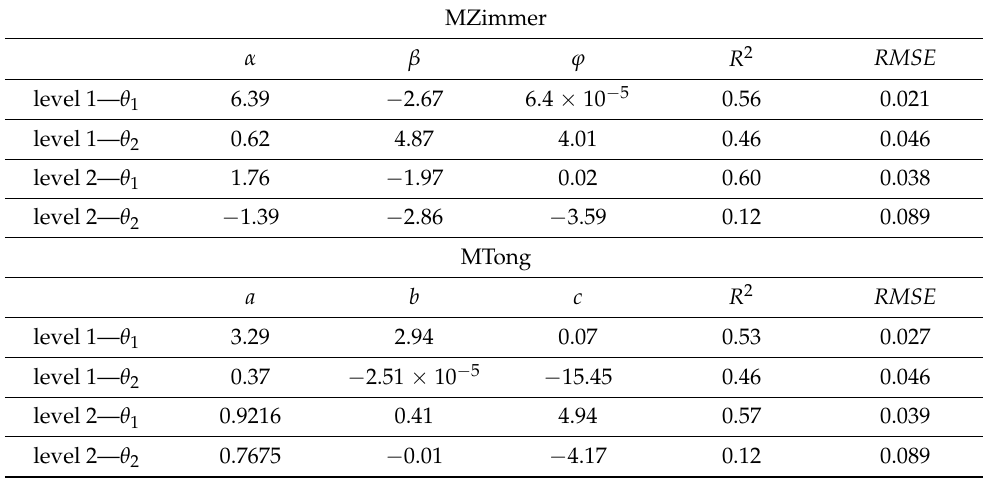
Table 4. Estimated parameters from the MTong and MZimmer models and statistical indices for soil thermal conductivities at level 1 and level 2 and soil water content at ). −0.10 m